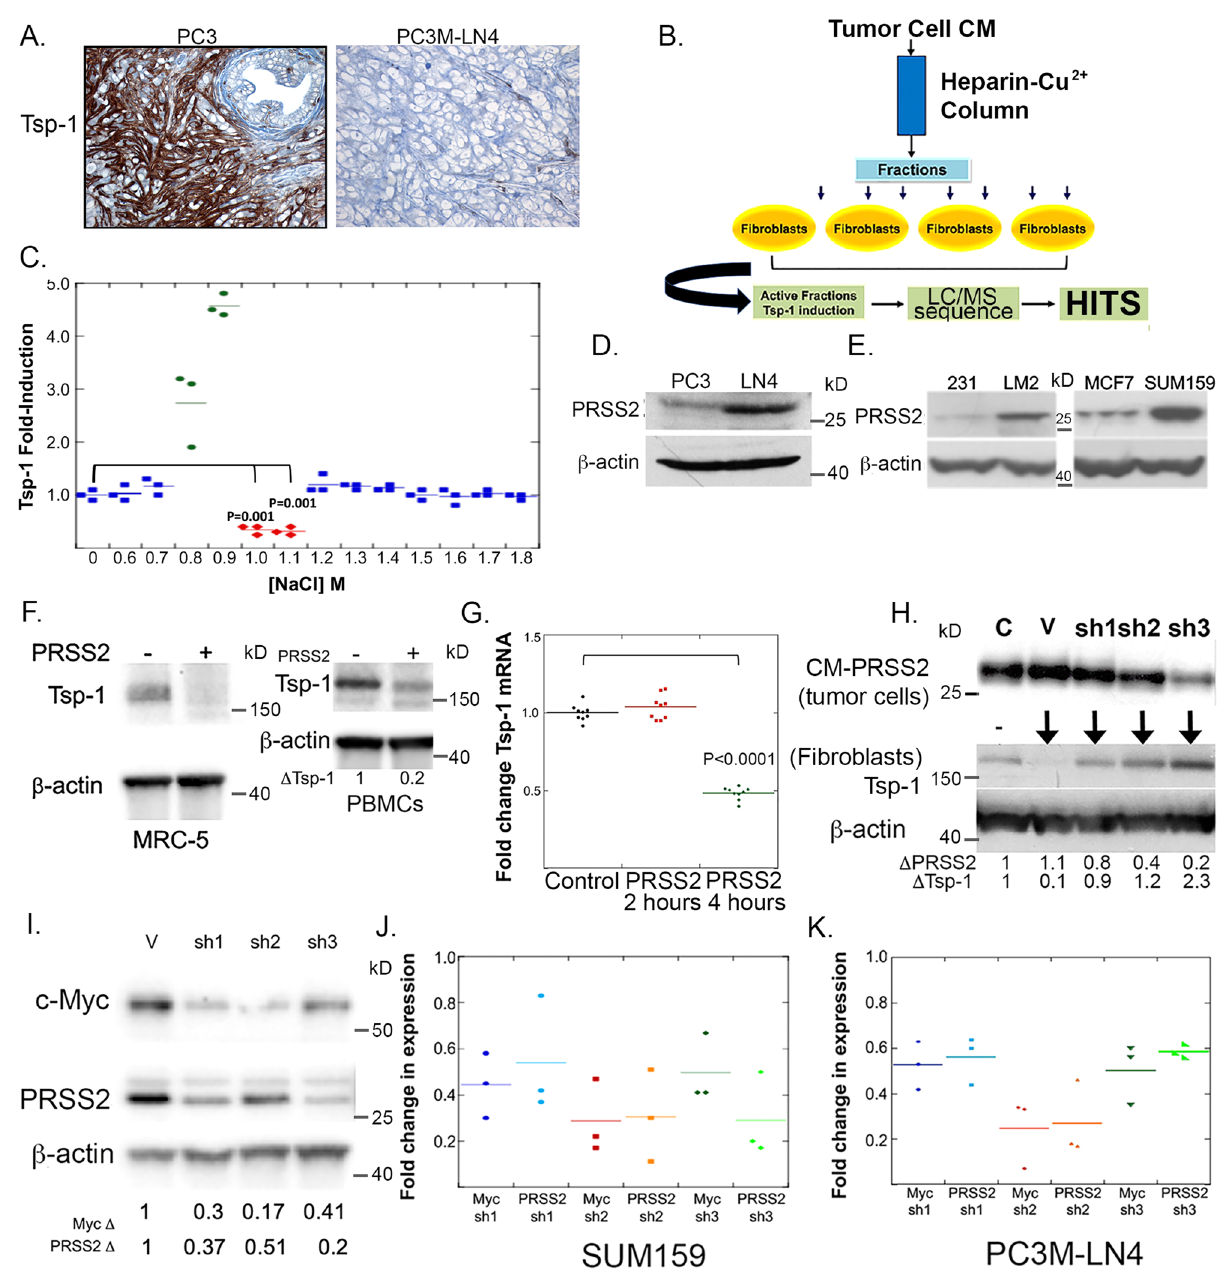
Fig. 1 | Breast and prostatecancer cellsrepressTsp-1 in a paracrinemannervia PRSS2. A Immunohistochemistry (IHC) of thrombospondin-1 (Tsp-1) expres- sionintumorsformedintheprostateglandofSCIDmicebyPC3andPC3M-LN4 prostate cancer cells (scale bar= 100 μ m) ( n =8 per group). B Schematic dia- gramofthe proteomic screening and identi fi cationof Tsp-1repressing protein in PC3M-LN4 conditioned media. C ELISA of Tsp-1 expression (normalized to total protein levels) in PC3M-LN4 fractions eluted from a Heparin-sepharose- Cu 2+ column( n =3). D WesternblotofPRSS2andactinproteinlevelsinPC3and PC3M-LN4 prostate cancer cells ( n = 3). E Western blot of PRSS2 and actin protein levels in MDA-MB-231 (231), MDA-MB-231-LM2 (LM2), MCF7 and SUM159 breast cancer cells ( n = 3). F Tsp-1 and actin levels in MRC5 fi broblasts and primary human peripheral blood mononuclear cells (PBMCs) that were untreated ( – ) or treated with recombinant human PRSS2 (+ ) ( n =3). G Plot of Tsp-1 mRNA fold change, measured by real-time quantitative RT-PCR in WI38